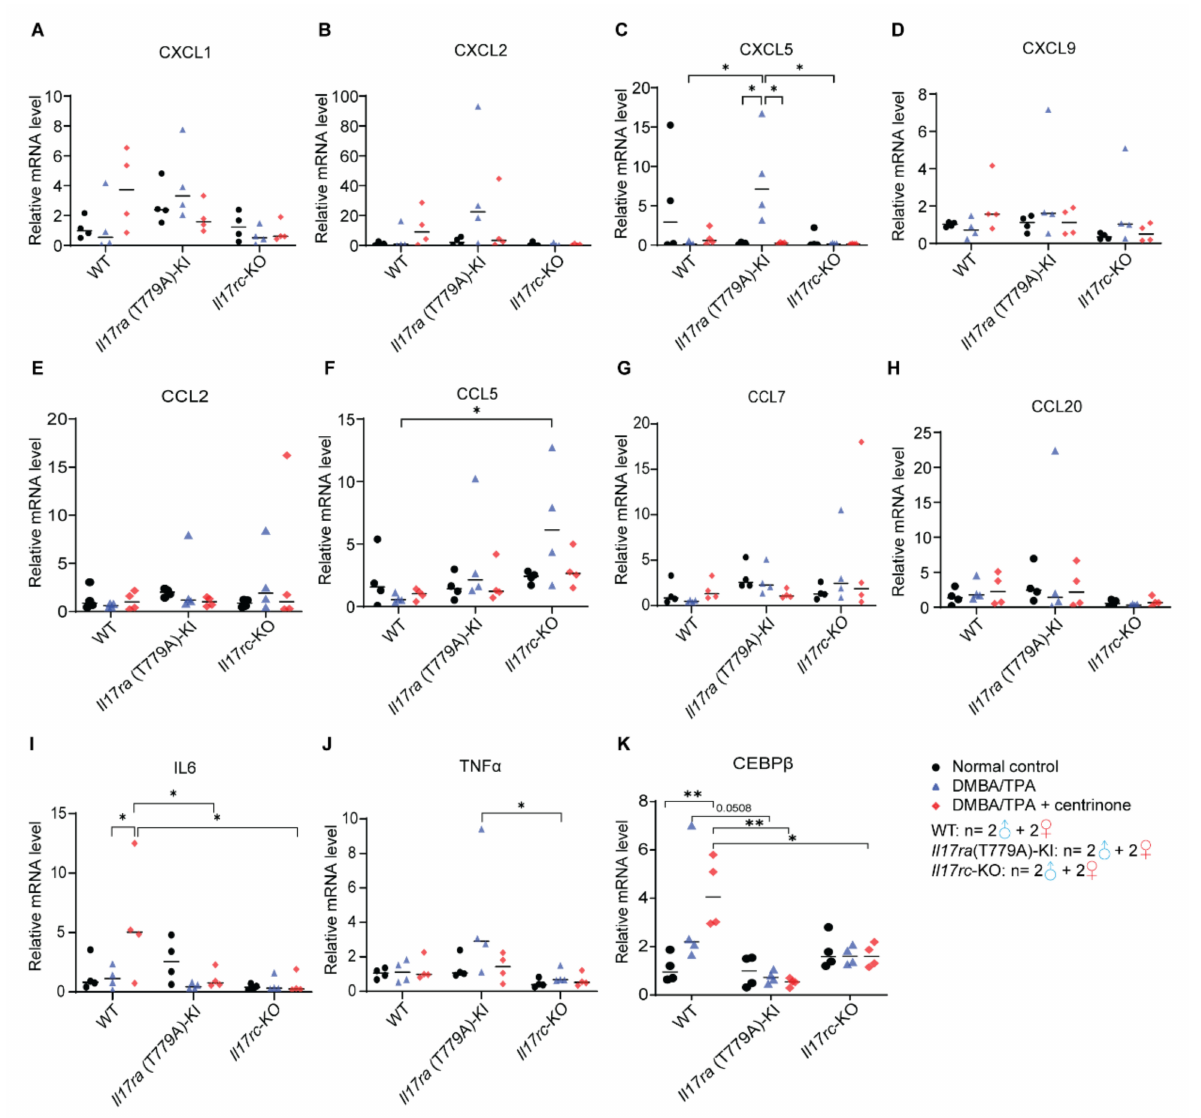
Figure 5. CEBP β -mediated downstream signaling is inhibited in the psoriasis model. Mouse skin was collected from 4 individuals of each genotype. Total RNA was isolated, and the expression levels of CXCL1 ( A ), CXCL2 ( B ), CXCL5 ( C ), CXCL9 ( D ), CCL2 ( E ), CCL5 ( F ), CCL7 ( G ), CCL20 ( H ), IL6 ( I ), TNF α ( J ), and CEBP β ( K ) were evaluated using real-time PCR. Normalized value was presented as mean ± SD. Statistical significance was assessed by one-way ANOVA with Tukey’s multiple comparison test. *— p < 0.05; **— p < 0.01. The numbers of male and female mice in each group are indicated in the